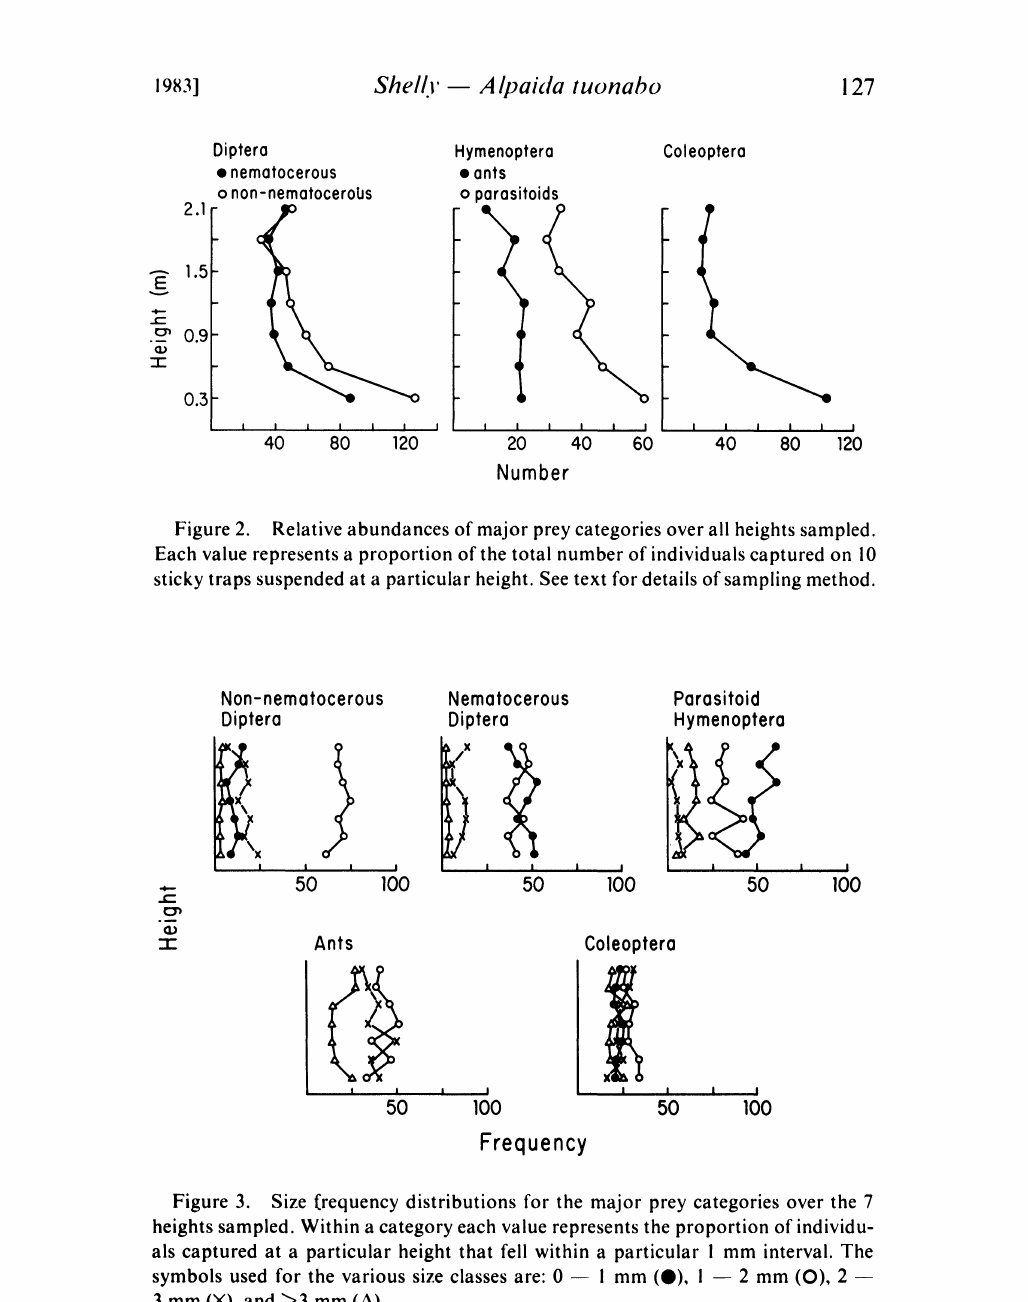
Figure 3. Size frequency distributions for the major prey categories over the 7 heights sampled. Within a category each value represents the proportion of individu- als captured at a particular height that fell within a particular mm interval. The symbols used for the various size classes are: 0 mm (O), 2 mm (O), 2 3 mm (), and >3 mm